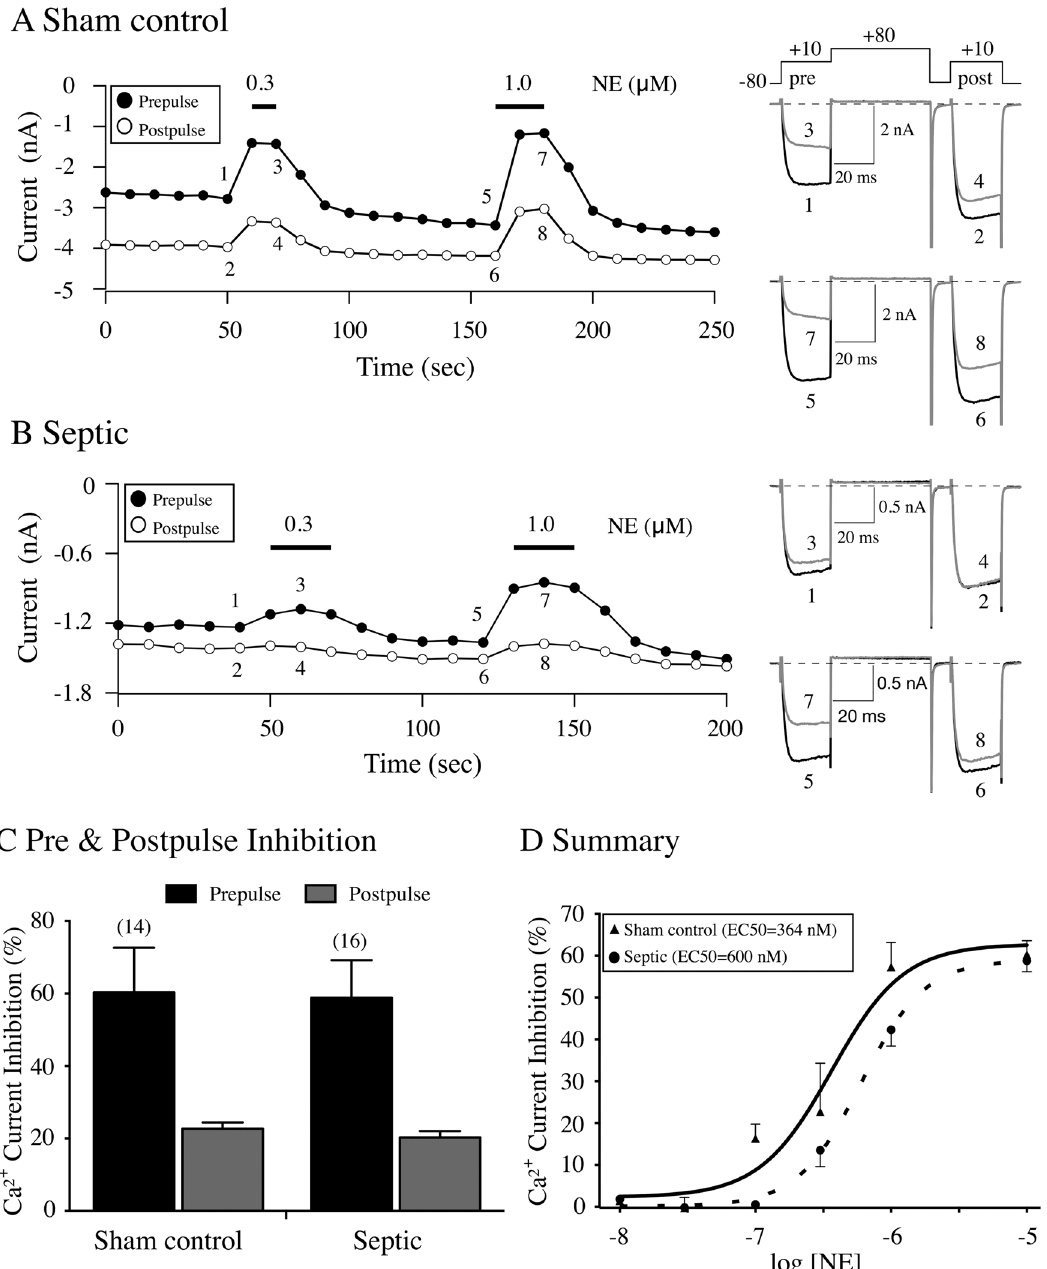
Fig 3. Time courses of Ca 2+ current amplitude for prepulse ( ● ) and postpulse ( (cid:1) ) acquired from the application of NE in acutely isolated CSMG neurons from sham control (A) and septic (B) rats 48 hr post-sepsis induction by CLP. Ca 2+ channel currents were evoked every 10 sec with the ‘ double-pulse ’ voltage paradigm (A, top right). The numbered current traces in A and B are shown to the right. C, summary bar graph illustrating the mean ( ± SE) prepulse inhibition (first test pulse to +10 mV) and postpulse inhibition (second test pulse to +10 mV) mediated by 10 μ M NE. The numbers in parenthesis indicate the number of neurons tested. D, NE concentration-response relationship of CSMG neurons from sham control ( ▲ ) and septic ( ● ) rats. Each data point represents the mean ( ± SE) NE-mediated prepulse current inhibition from 4 to 16 neurons, except for 1 and 30 nM where n = 1. The smooth curves were obtained by fitting the points to the Hill equation and the EC 50 (nM) values, shown in the legend, were significantly (P < 0.001) different from each